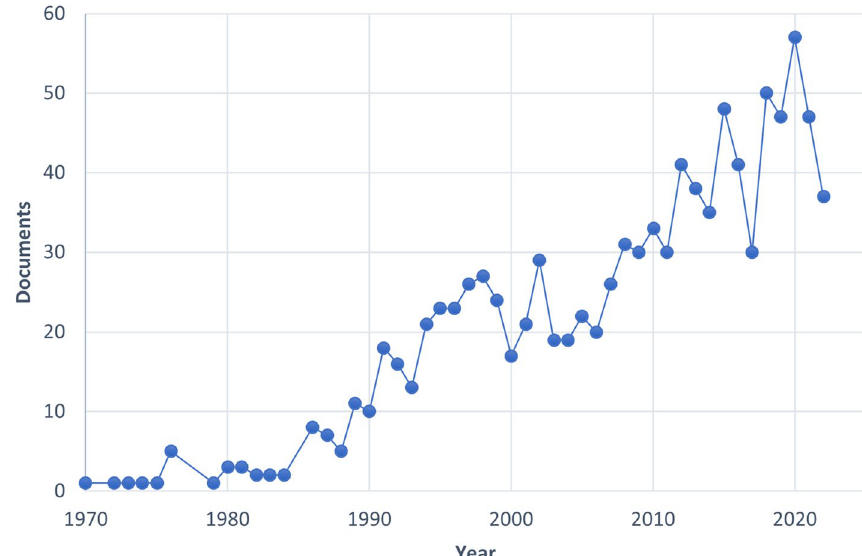
Fig. 3 Annual scientific production of articles on thermostable